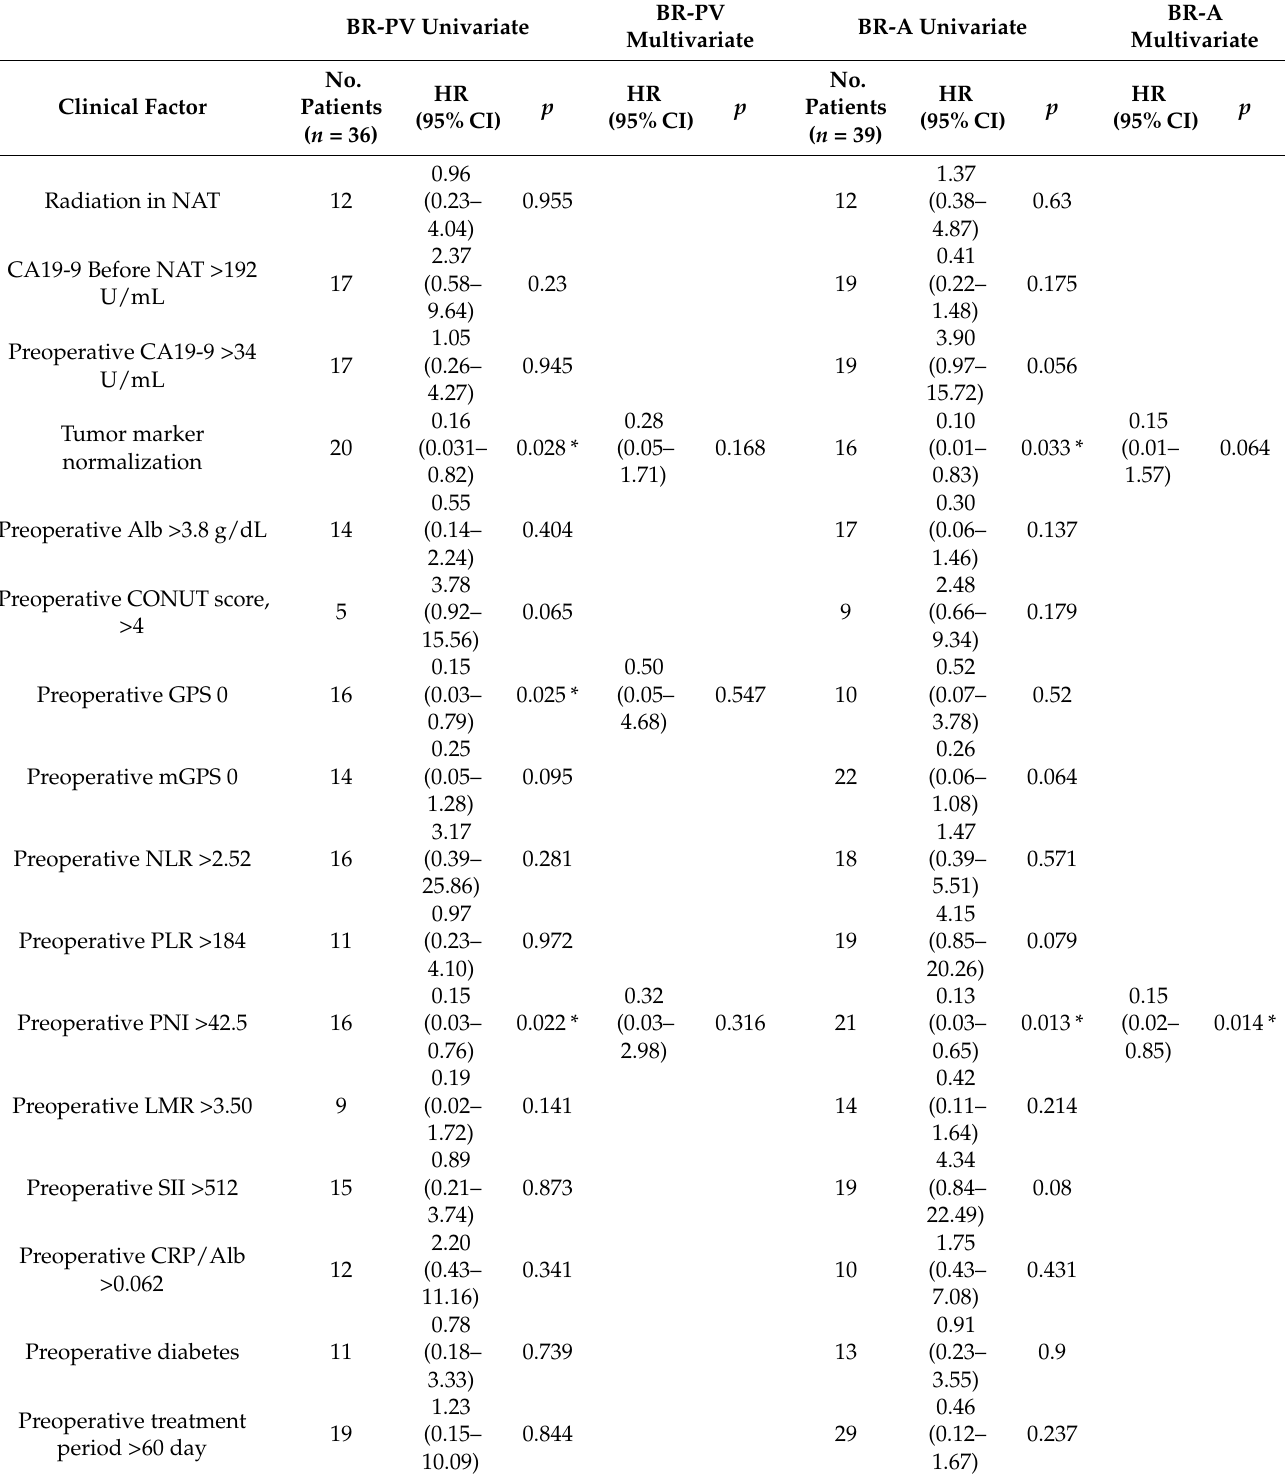
BR-PV Univariate